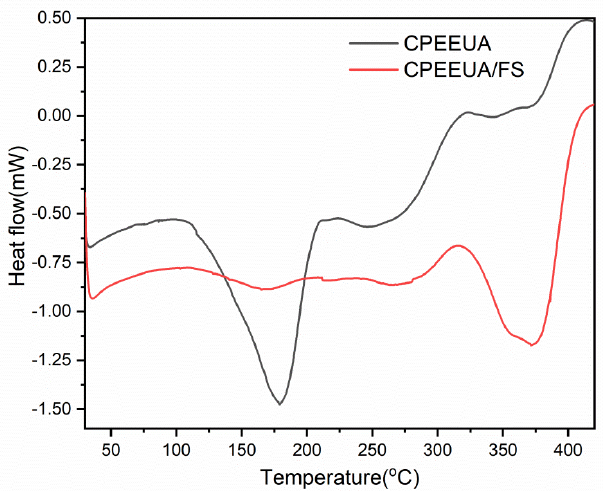
Figure 6. DSC of CPEEUA-40, CPEEUA/FS-40.